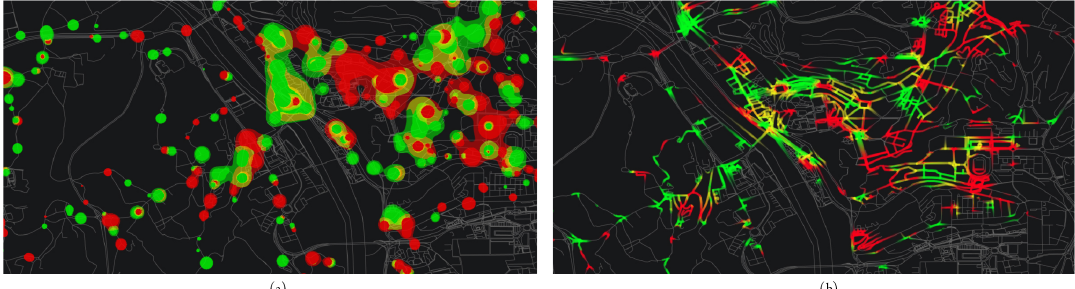
Figure 22. Point ( a ) and vertex-based ( b ) metaballs visualization technique for detecting anomalies on the bus stops of the city of Coimbra, Portugal [84] (extracted from [86]). Colors are related to the sign of the deviation of average number of passengers, with red and green representing above- and below-average deviations, respectively.